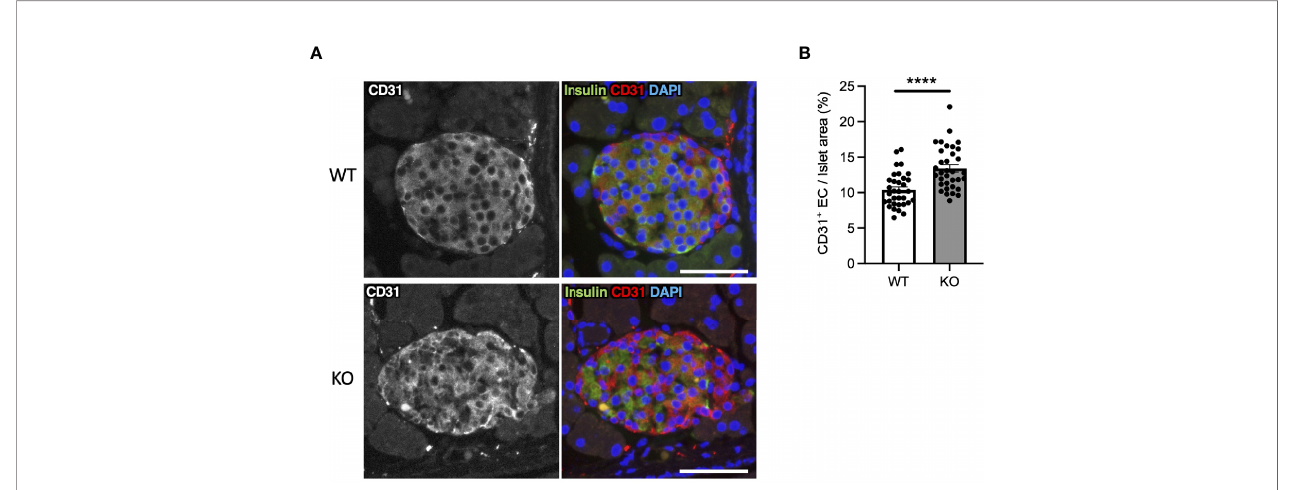
FIGURE 6 | Hypervascularization in the islets of Wolfram syndrome mouse model. (A) Representative immuno fl uorescent images of islets from Wfs1 wild-type (WT) and whole-body knockout 129S6 (KO) male mice at 10 months of age. Scale bars 50 µm. (B) Quanti fi cation of endothelial cell marker (CD31) positive area and islet area composition (WT, n=33; KO, n=34). Data are shown as mean ± SEM, ****P <